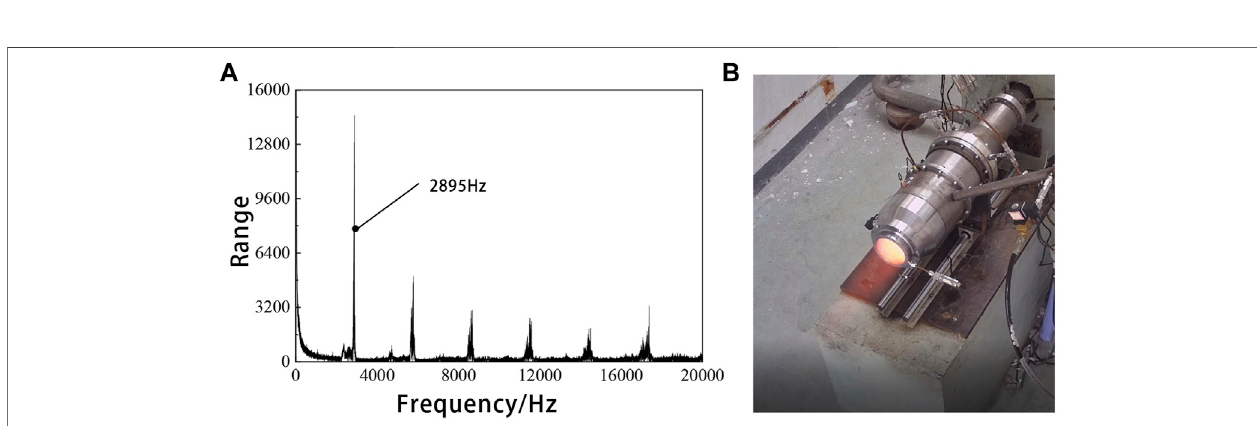
FIGURE 15 | Results of operating at T 0 (cid:1) 650K, _ m air (cid:1) 1 . 5kg/s, φ (cid:1) 1 . 086. (A) The FFT frequency distribution by P 1 ; (B) The Photograph of RDE.